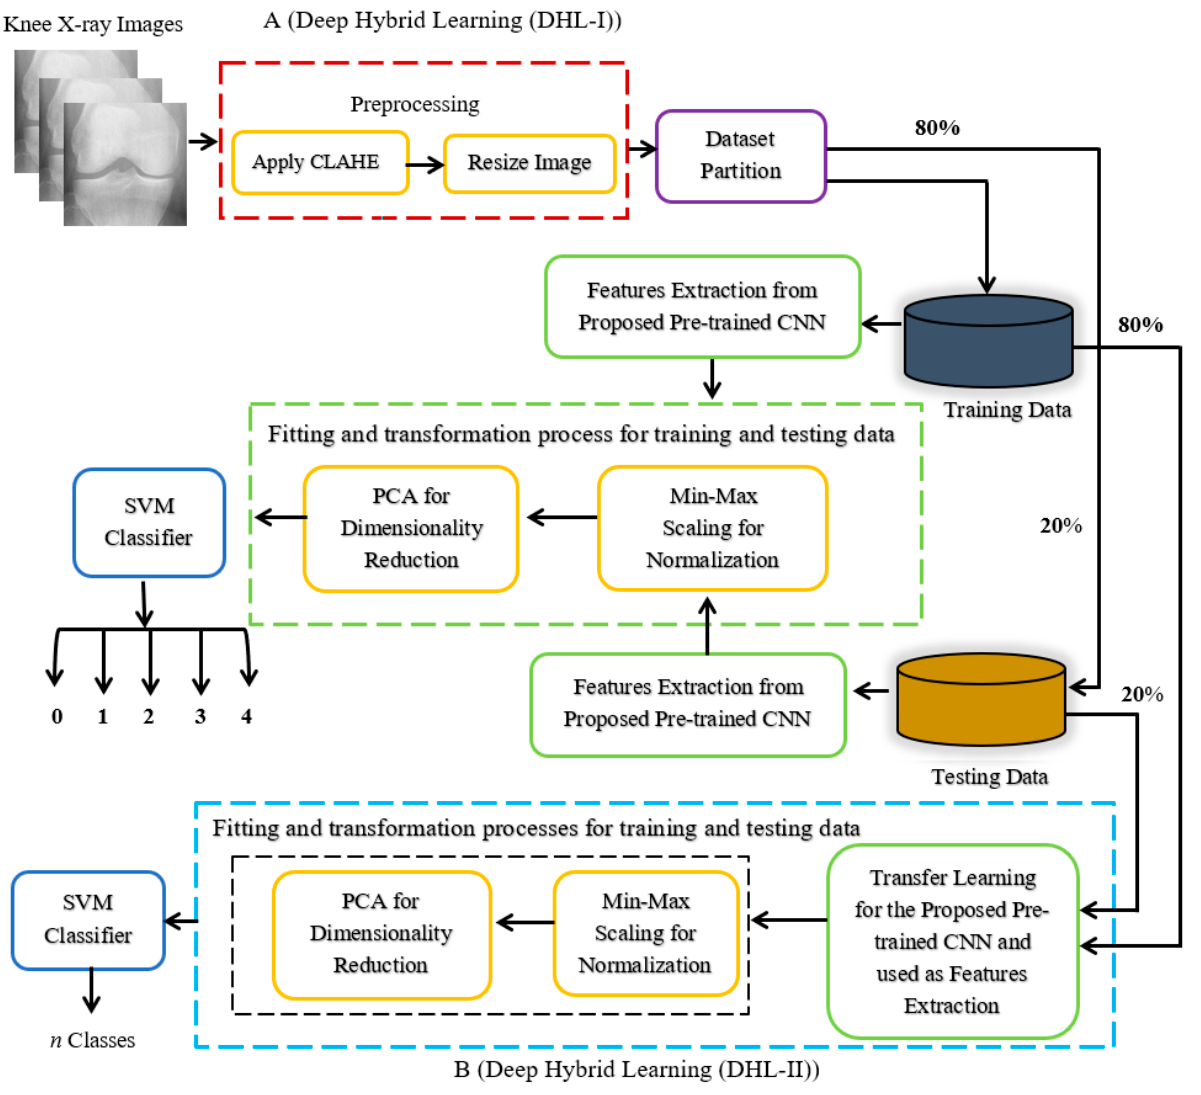
Figure 6. The framework of the proposed approach. Part ( A ), DHL-I presents a proposed model for knee OA classifications using KL grade, while part ( B ), DHL-II provides a detailed overview of the proposed knee OA classifications based on n-class